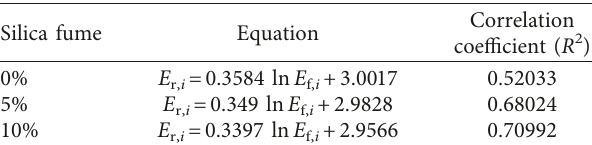
Figure 12: Relationship between flexural loading E energy E r . Table 3: Relationship between flexural loading E energy E r